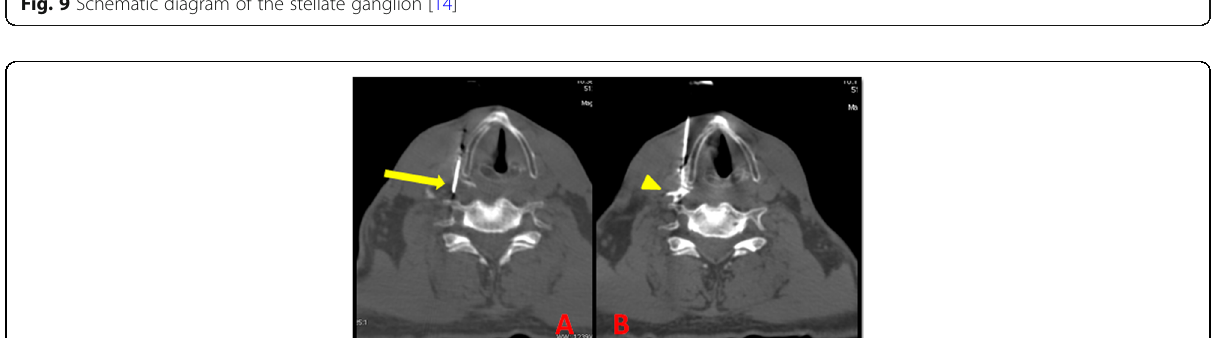
Fig. 9 Schematic diagram of the stellate ganglion [14]